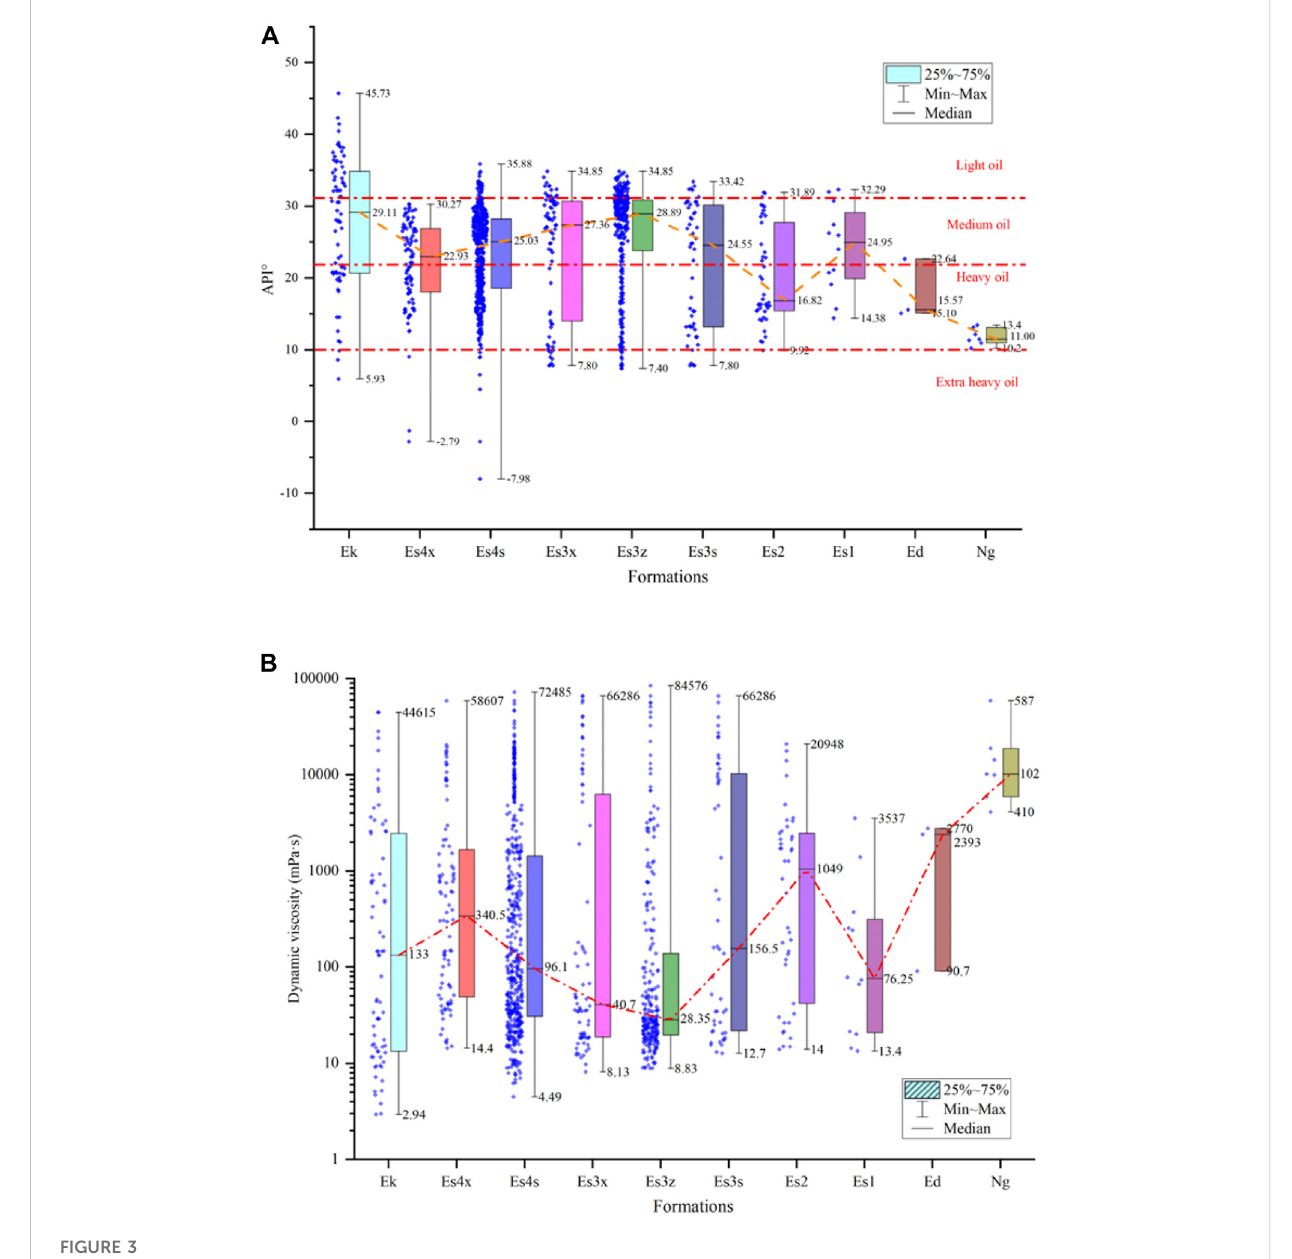
development of different levels of red beds (Zhan et al., 2019; Tao et al., 2022). The Shahejie formation is dominated by semi- deep to deep lake mudstone and siltstone sediments and coarse deltic sandstone interbedded with conglomerates. The Dongying formation comprises sandstones, mudstones and some conglomerates that developed in deltaic and shallow lacustrine environments. The Guantao and Minghuazhen formations are characterized by braided stream conglomerates, sandstones and fl oodplain siltstones. During the late Oligocene and early Miocene, regional tectonic uplift caused different degrees of erosion throughout the Dongying Sag (Chang et al., 2018; Liu et al.,